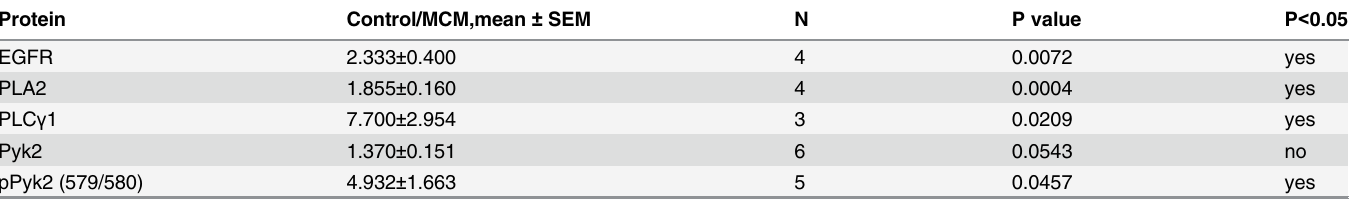
Only proteins that belong to signaling pathways related to migration were selected. The level of proteins was measured as a relative density of fl uorescent signal. N indicates the number of repeated